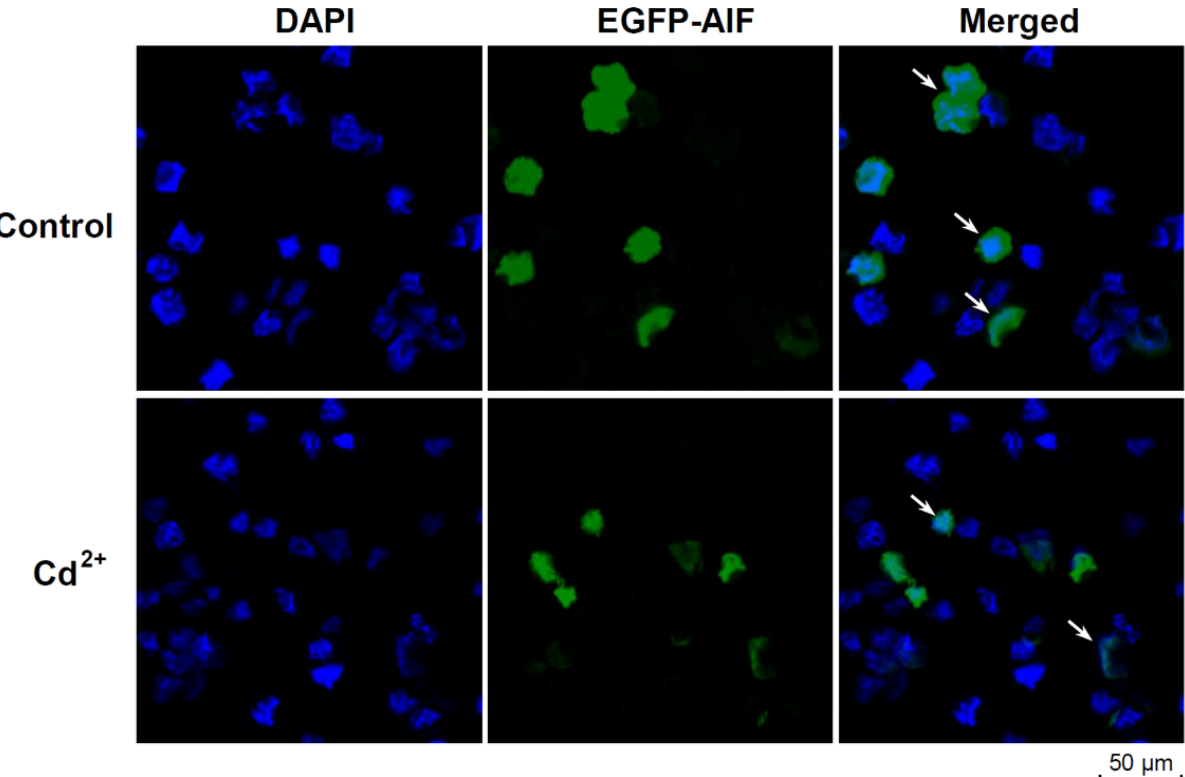
Figure 5. Subcellular localization of Hl AIF-2 in HEK293T cells. “DAPI” represents the DAPI-stained cell nuclei; “EGFP-AIF” represents the EGFP-labeled HlAIF-2 protein; “Merge” represents the combination of cell nuclei and Hl AIF-2 protein. Cd 2+ treatment (12 h) could trigger Hl AIF-2 nuclear translocation, compared with the “Control” group. The arrows indicate the typical cells located in cytoplasm or translocated into nuclei.